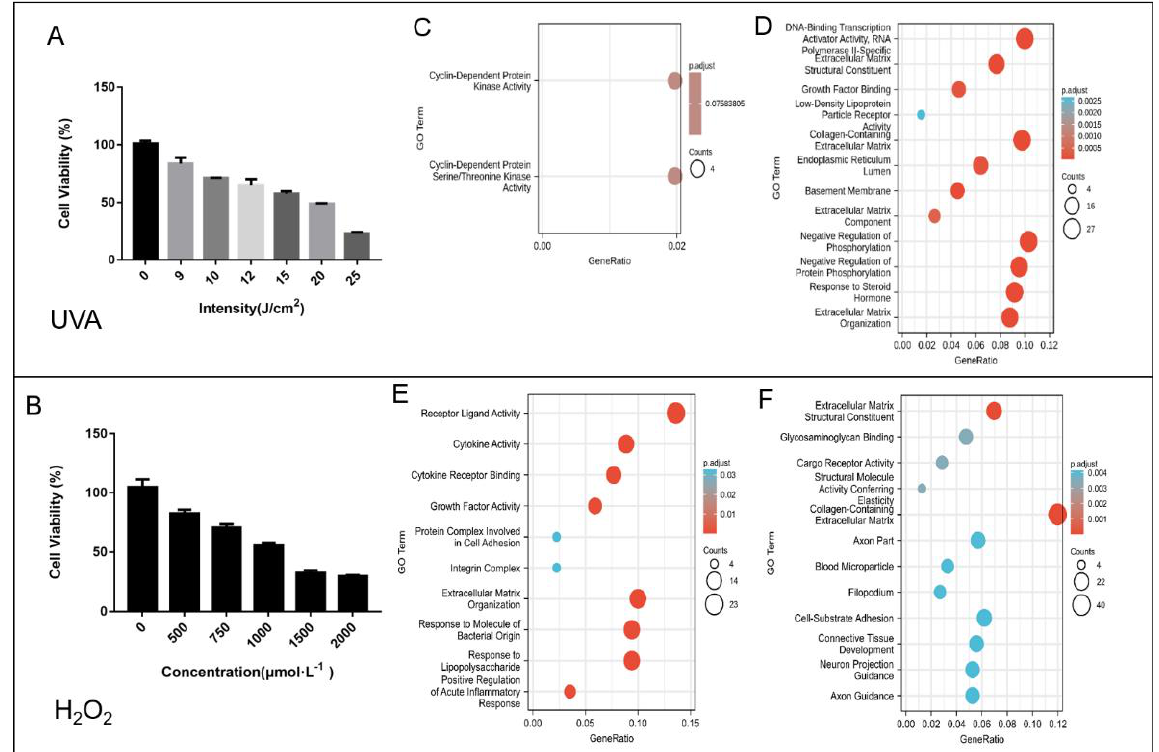
Figure 1. The toxicity of UVA ( A ), H 2 O 2 ( B ) to HSF cells, and the diagrams of the DEG GO terms ( C – F ). The results were expressed as mean ± SD ( n = 6). The Model in ( A ) was established by UVA (15 J/cm 2 ) irradiation; and the Model in ( B ) was established by H 2 O 2 (1000 μ mol/L for 30 min) treatment. In the bubble diagram, the vertical axis indicated GO terms and the horizontal axis represented gene ratio involved in each term. The size of dots indicated the number of genes in the GO term. The color of dots exhibited the significance. ( C , E ), differentially upregulated genes; ( D , F ), differently downregulated genes.